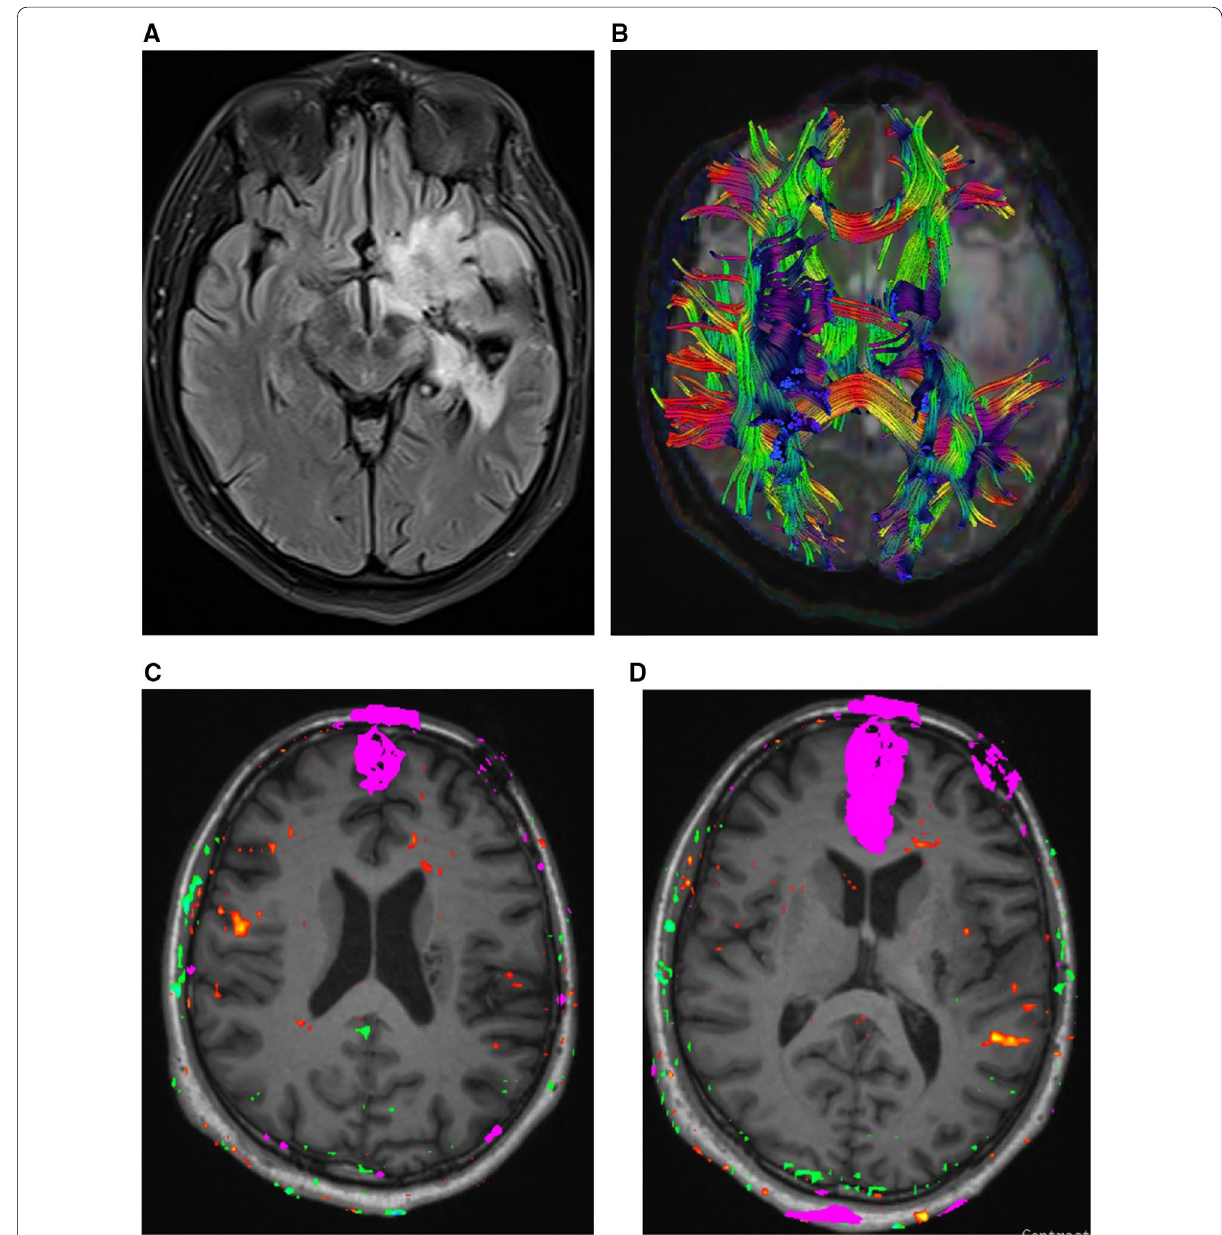
Fig. 1 a Axial FLAIR image-heterogeneous hyperintense signal noted in left frontotemporal region corresponding to the residual glioma with postoperative encephalomalacic changes in left temporal lobe. b Tractography image obtained using DTI images shows disruption as well